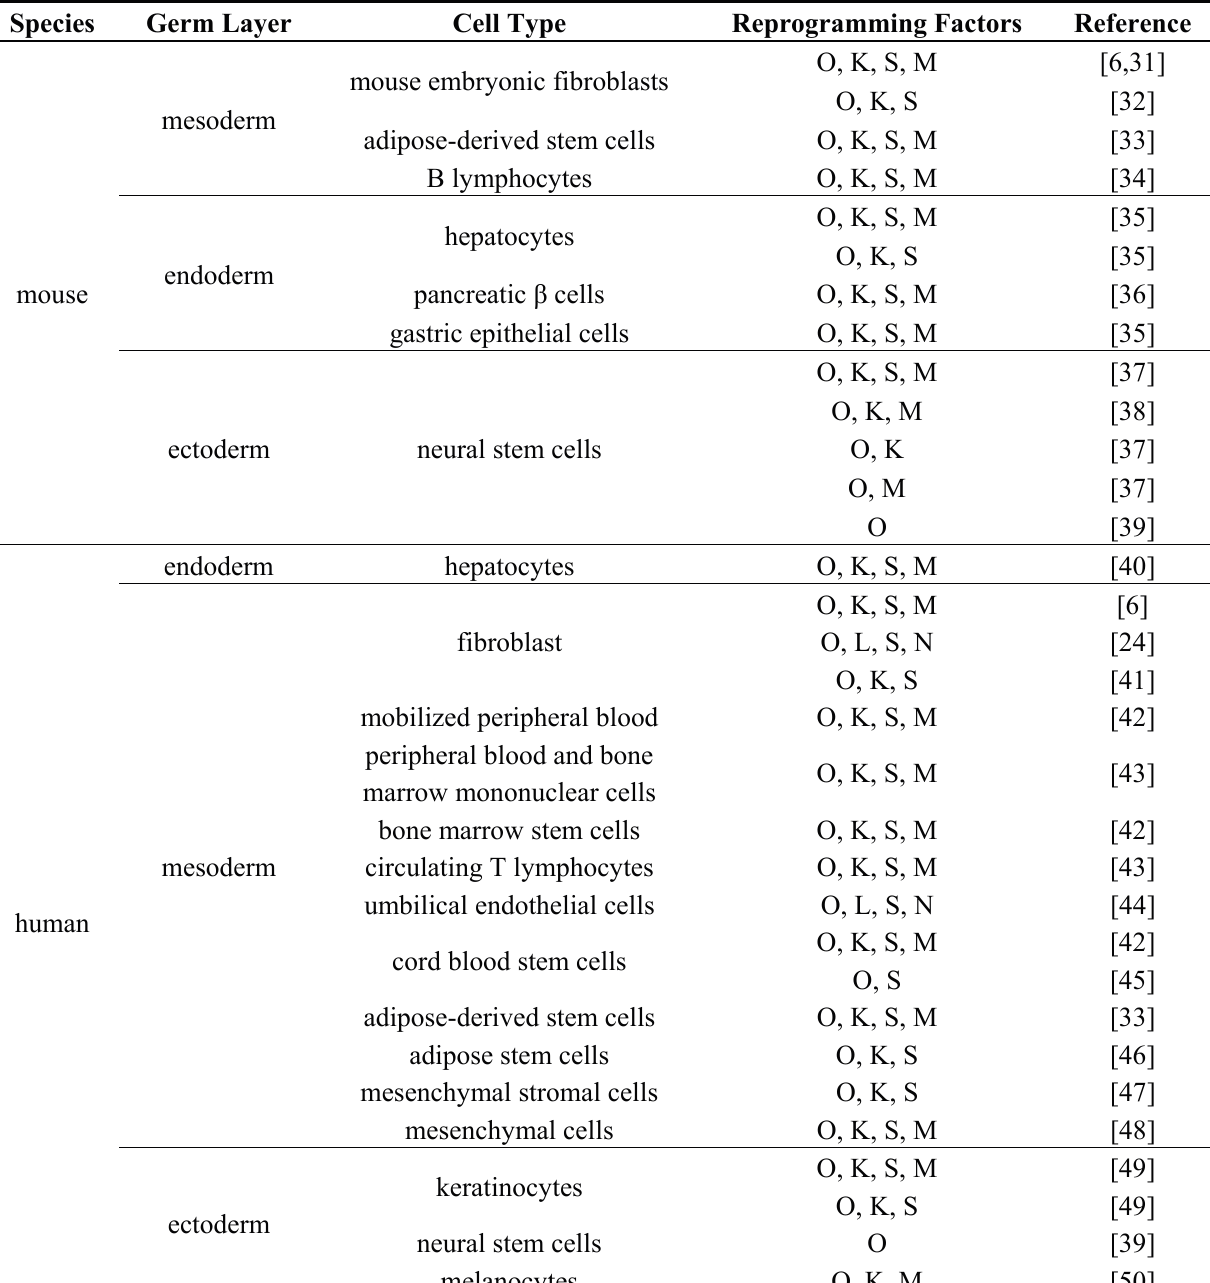
Table 2. Human and mouse iPSCs from different somatic cell